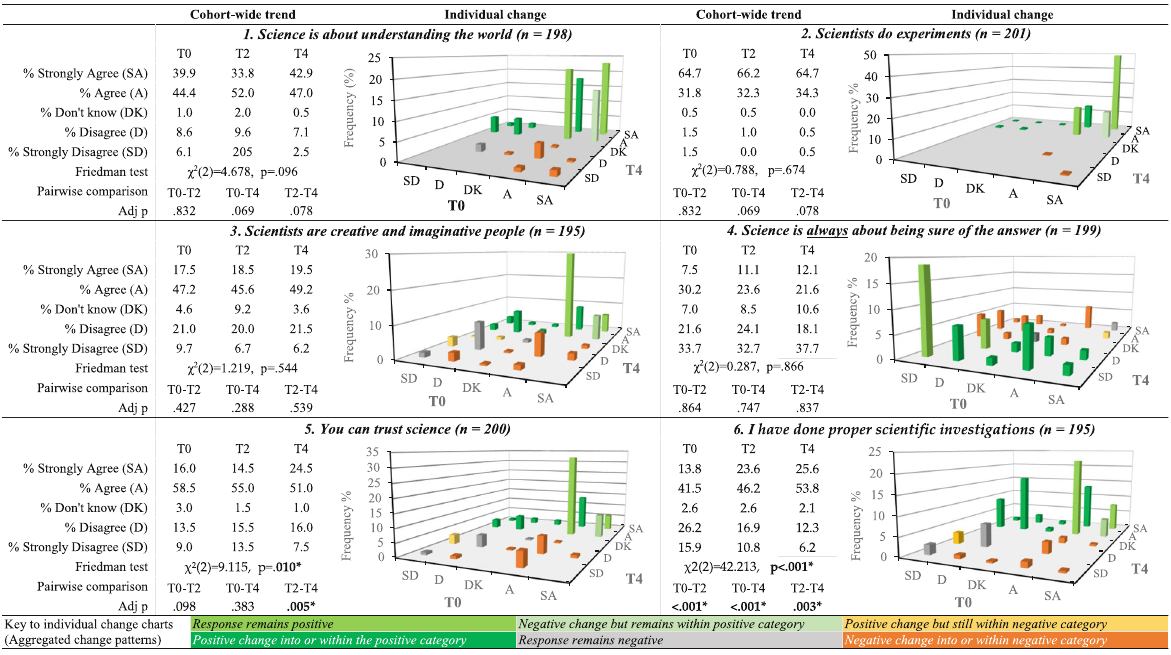
Table 2 Perceptions of science: matched pre-post responses showing cohort-wide and individual change trends, n = 201